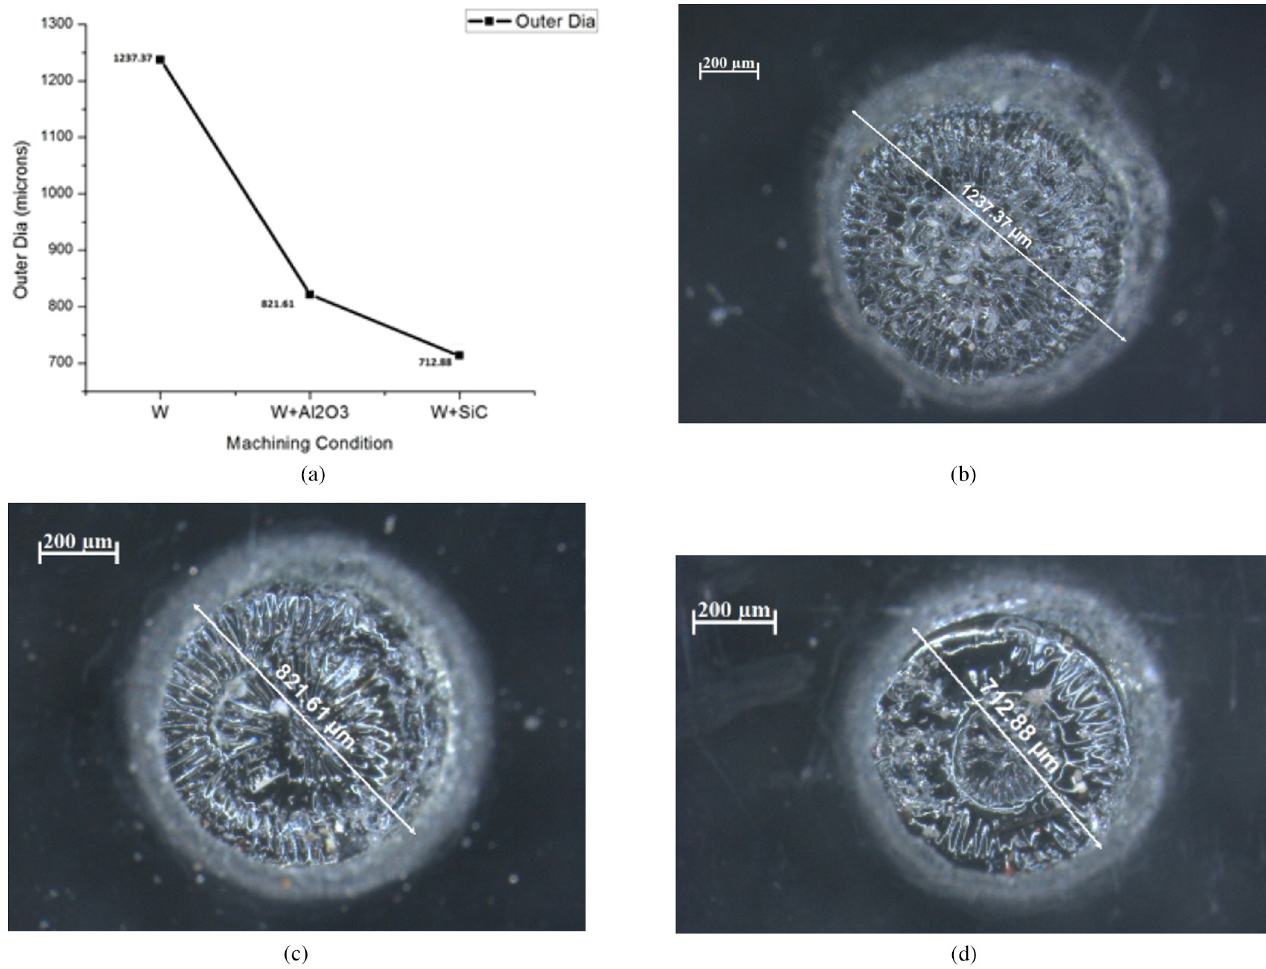
Fig. 3. (a) The in fl uence of different machining conditions on outer diameter. (b) Outer diameter of the machined hole with Conventional ECDM process electrolyte. (c) Outer diameter of the machined hole with Al 2 O 3 abrasives mixed ECDM process. (d) Outer diameter of the machined hole with SiC abrasives mixed ECDM process.